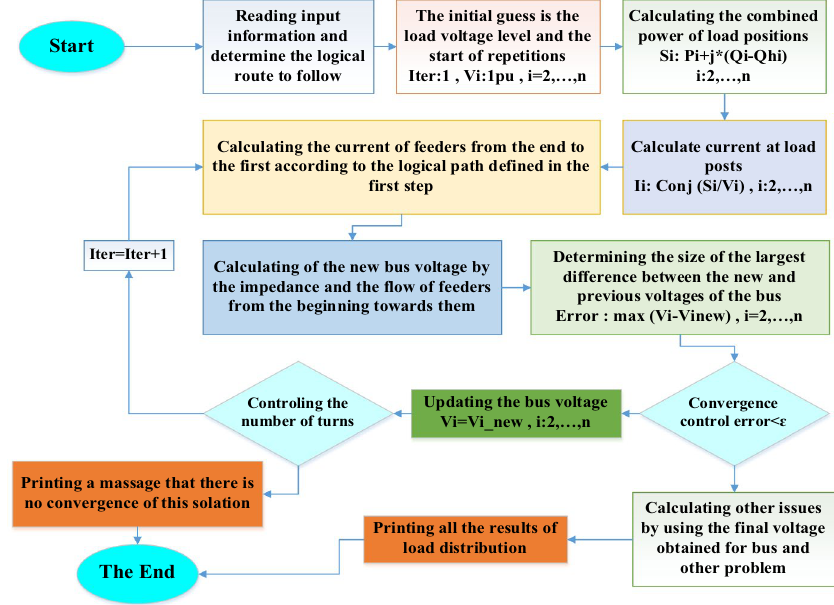
Fig. 5 Flowchart designed to coordinate with backward/forward sweep load